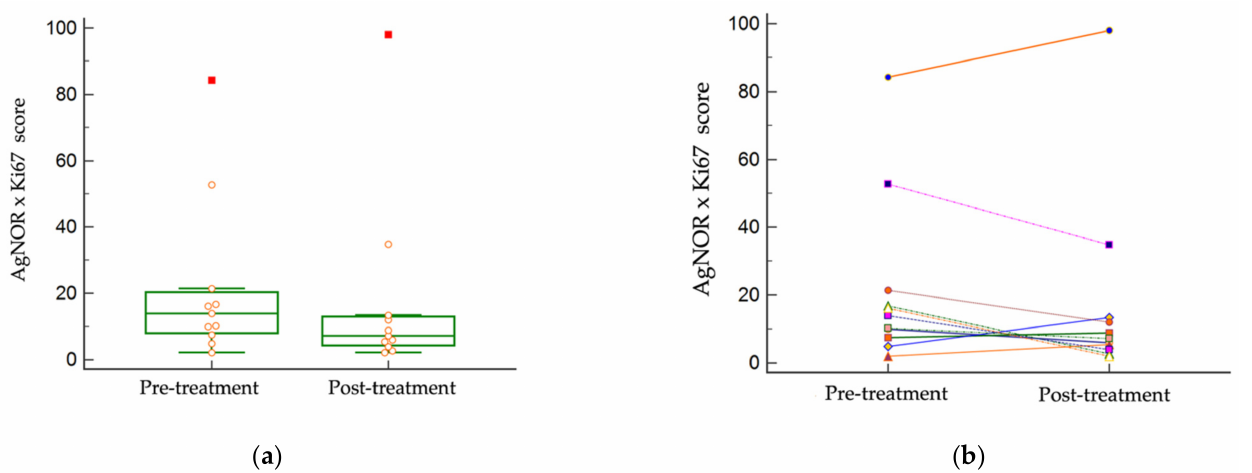
Figure 5. AgNORxKi67 scores in paired tumor samples. There was no statistically significant difference between pre- and post-treatment AgNORxKi67 scores ( p = 0.2046). ( a ) The distribution of AgNORxKi67 scores pre- and post-treatment. ( b ) Individual tumor paired AgNORxKi67